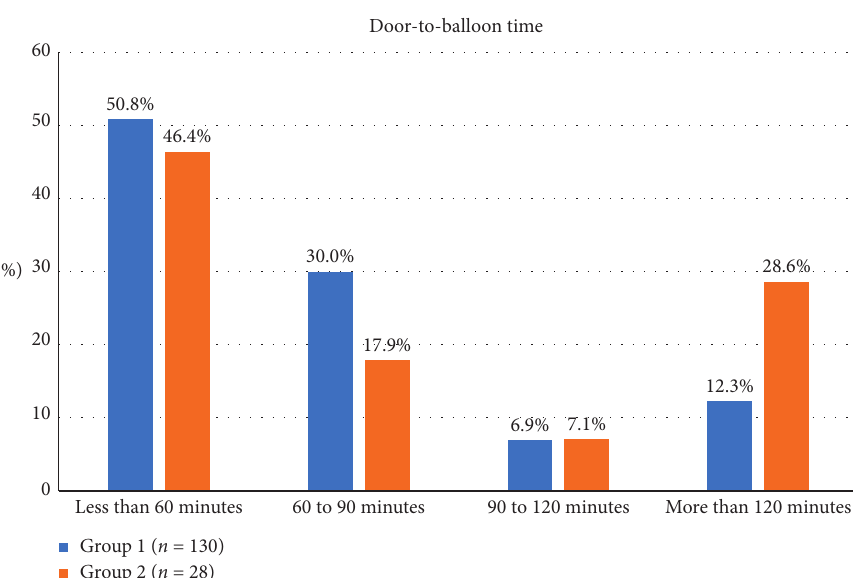
Figure 2: Distribution of time sequence between the two groups. The percentage of door-to-balloon time more than 120 minutes in group 2 was greater than that in group